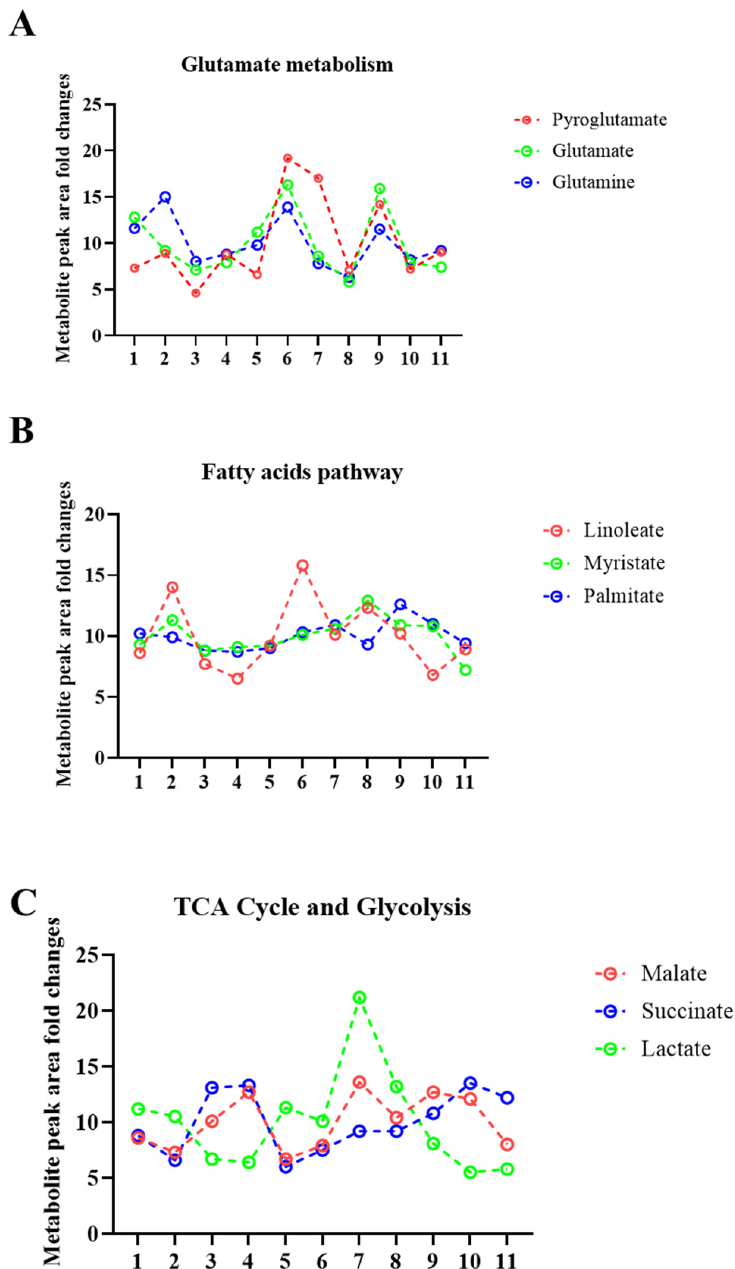
Figure 4. Sweat EVs exhibit metabolic qualities. ( A ) Metabolite signatures of glutathione and glutamate pathways. The metabolites are pyroglutamate, glutamate, and glutamine. ( B ) Metabolite signatures of the fatty acid pathway. The metabolites are linoleate, palmitate, and myristate. ( C ) Metabolite signatures of the TCA cycle and glycolysis pathways. The metabolites are malate, succinate, and lactate. Data are metabolite peak area fold changes ± SEM after normalization to the total EVs concentrations (particles/mL) and to the negative control (patch without sweat sample). n = 11.